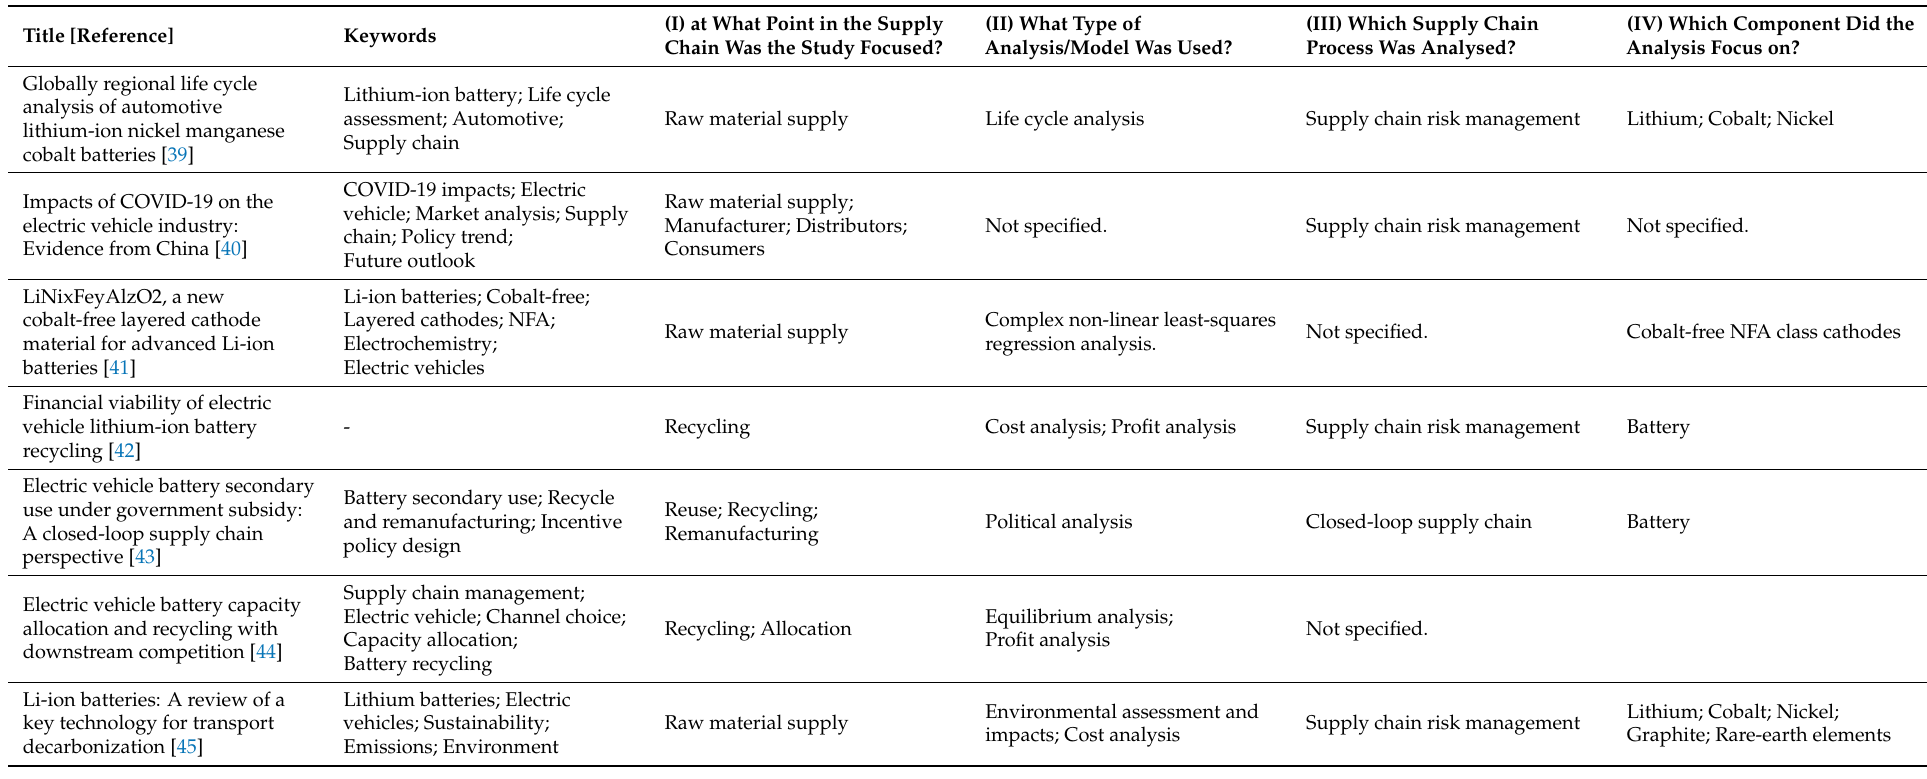
Table A3. PRISMA meta-analysis of documents found related to electric vehicles supply chains. (continuation).